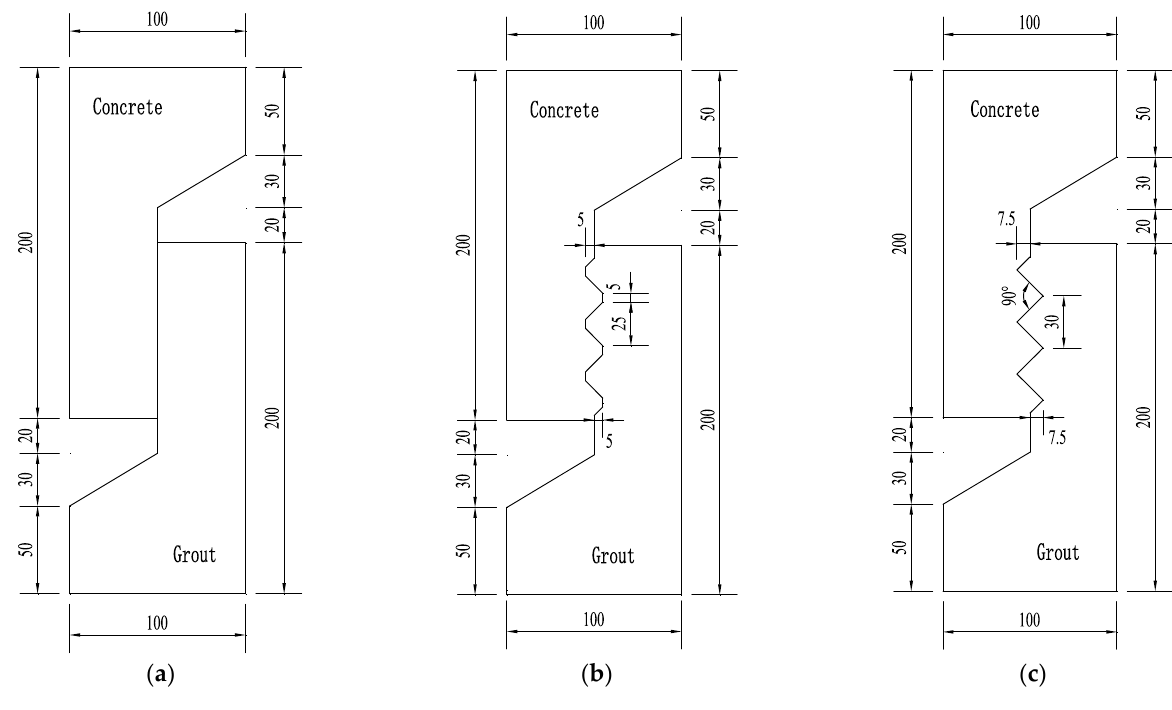
Figure 1. Size and configuration of the direct shear specimens (in mm): ( a ) smooth interface; ( b ) trapezoidal interface; ( c ) triangle interface. Table 1. Parameters of the specimens for the direct shear test.